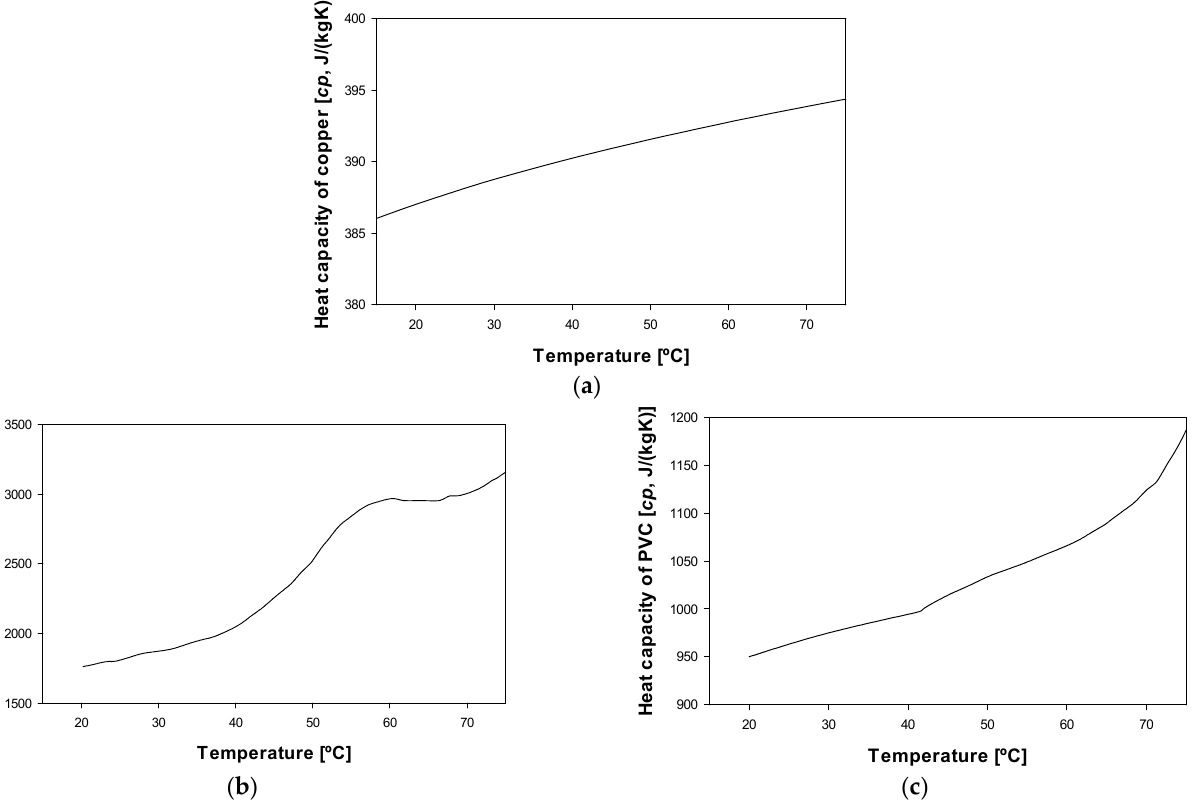
Figure 2. Temperature evolution of the specific heat capacity c p of the different cable materials: ( a ) Copper [28]. ( b ) XLPE [29]. ( c ) PVC [30].